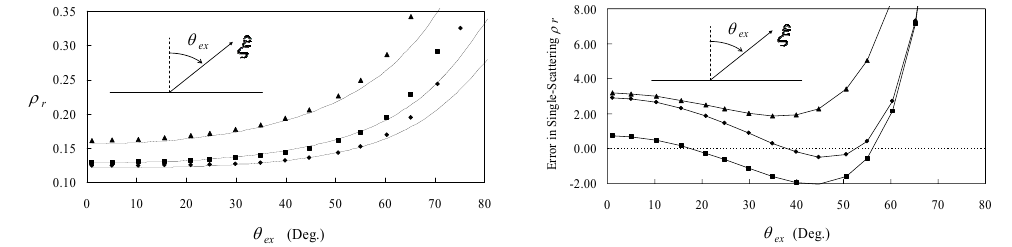
Figure 1. ( Left Panel ) ρ for a Rayleigh-scattering slab at 412 nm in the perpendicular plane ( φ − φ 0 = 90deg) computed using Equation (4) (symbols) and full scalar radiative transfer theory (lines). The angle the radiance exits the top of the atmosphere is θ ex , where θ ex = π − θ = cos − 1 ( | u | ) . The solar zenith angles are θ 0 = 20deg (filed circles), 40deg (filled squares), and 60deg (filled triangles). ( Right Panel ) Error (%) in ρ r computed using Equation (4). Positive error indicates that the single-scattering ρ r is too high. (Taken from Gordon